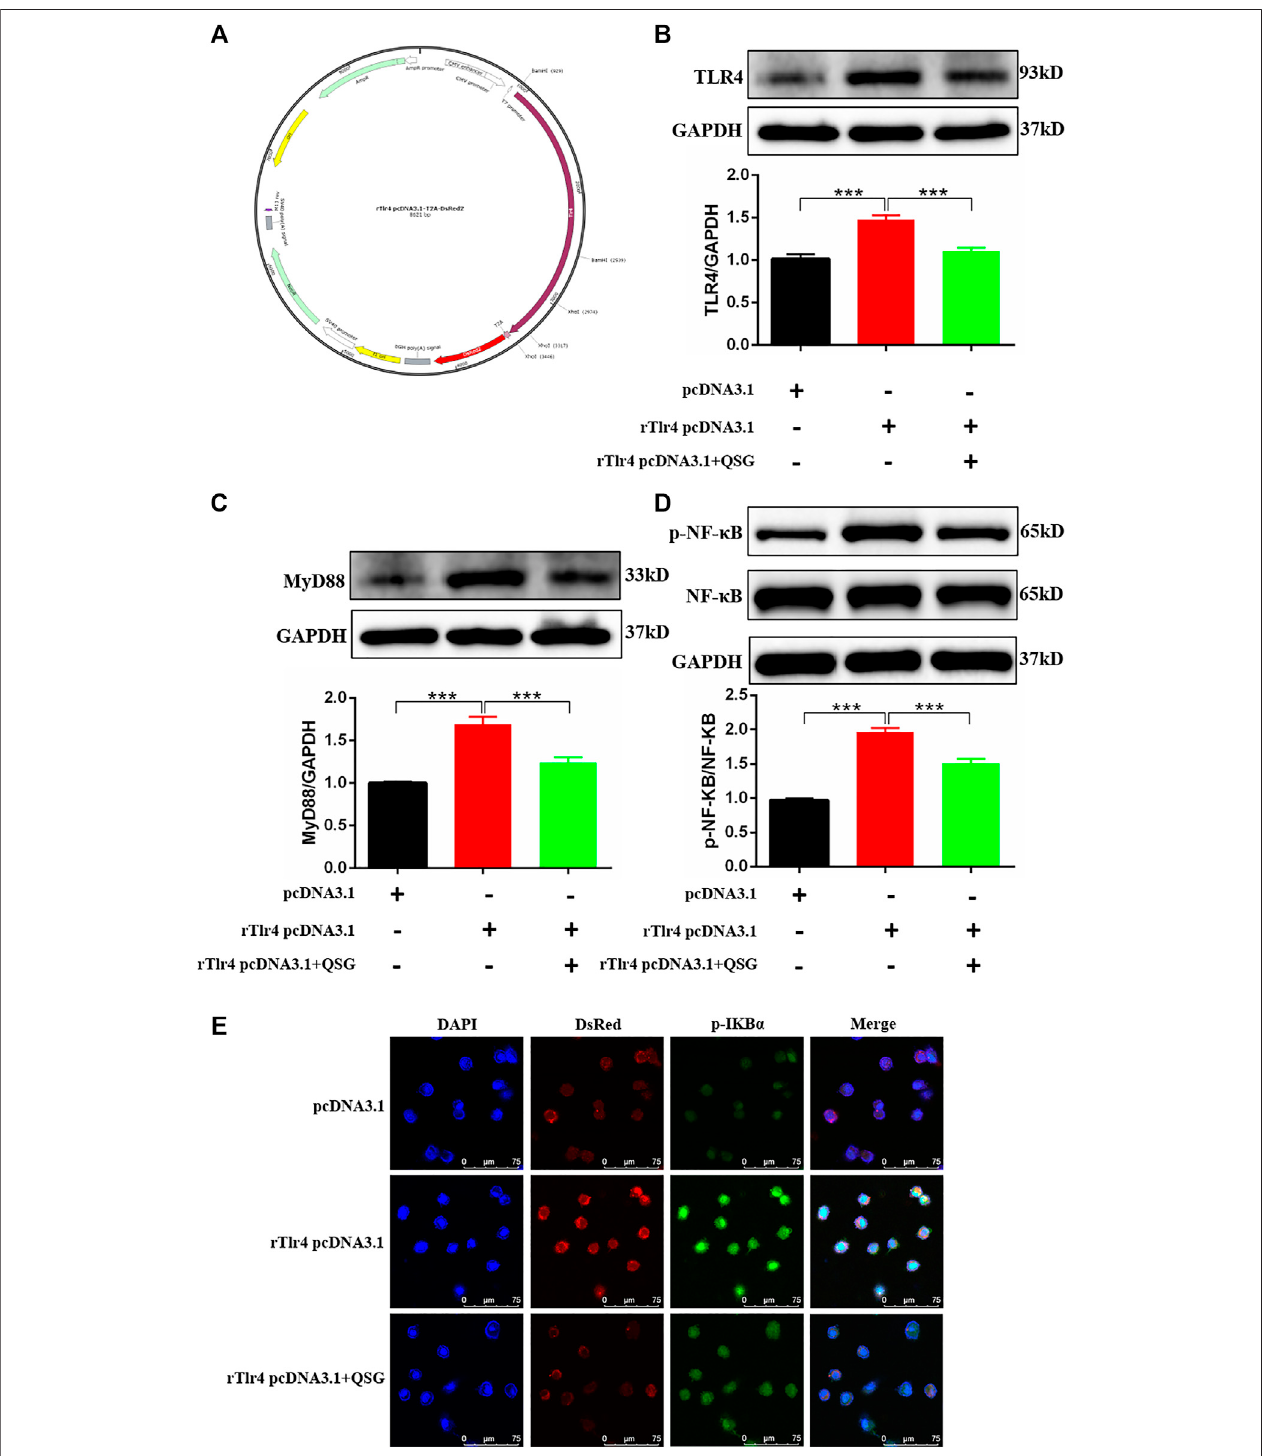
FIGURE 5 | Validation of the regulatory effect by QSG on the TLR4-MyD88-NF- κ B p65 pathway. (A) The structure of rTlr4 pcDNA3.1-T2A-DsRed plasmid. Representativewesternblotimages andquanti fi cationofTLR4 (B) ,MyD88 (C) ,p-NF- κ Bp65andNF- κ Bp65 (D) inH9C2 cells,N=3per group.GAPDHwasusedasa loadingcontrol.* p < 0.05,** p < 0.01,*** p < 0.001vs.rTlr4pcDNA3.1-T2A-DsRedtransfectedgroup. (E) Representativeimmuno fl uorescencestainingimagesofp-I κ B α and DsRed from different groups. H9C2 cells were transfected with rTlr4 pcDNA3.1-T2A-DsRed to check the overexpression of TLR4. pcDNA3.1-T2A-DsRed transfected cells were used as a negative control. * p < 0.05, ** p < 0.01, *** p < 0.001 vs. rTlr4 pcDNA3.1-T2A-DsRed transfected group.